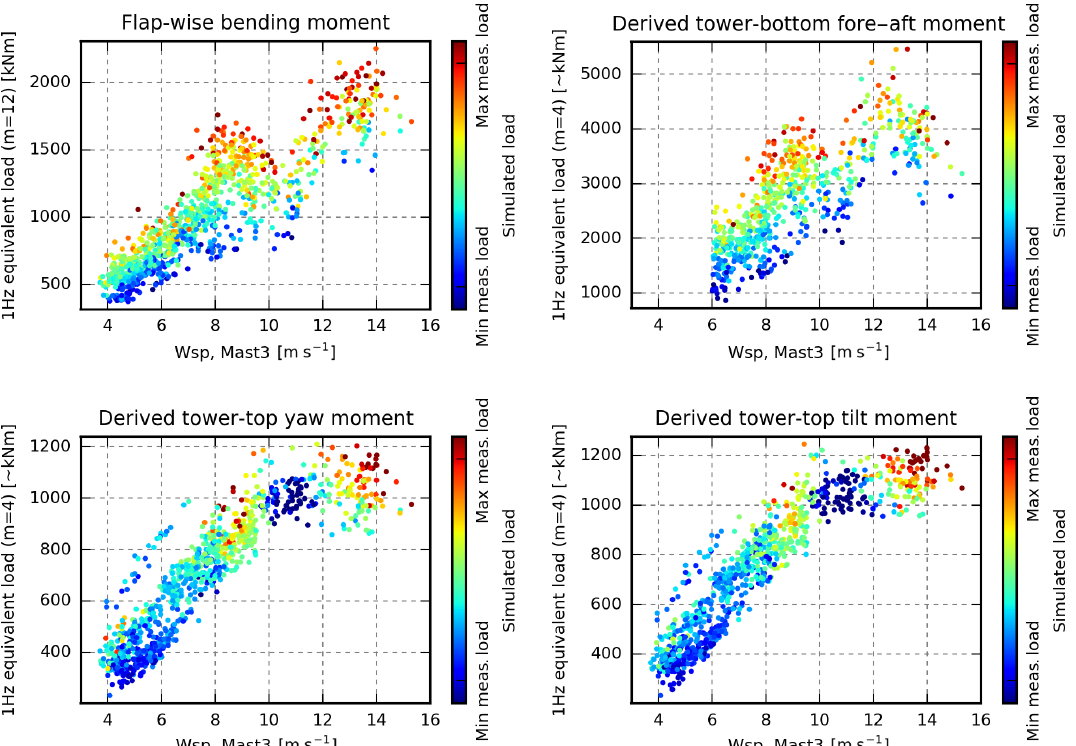
Figure 19. Equivalent measured loads, coloured by the corresponding simulation result. The simulations are performed using inflow infor- mation from the pitot tube, similar to Case 5 (but only one seed per period). If the simulated load equals the maximum measured load at the current wind speed, then the observation is red, whereas observations where the simulated load equals the minimum load measured at the current wind speed are